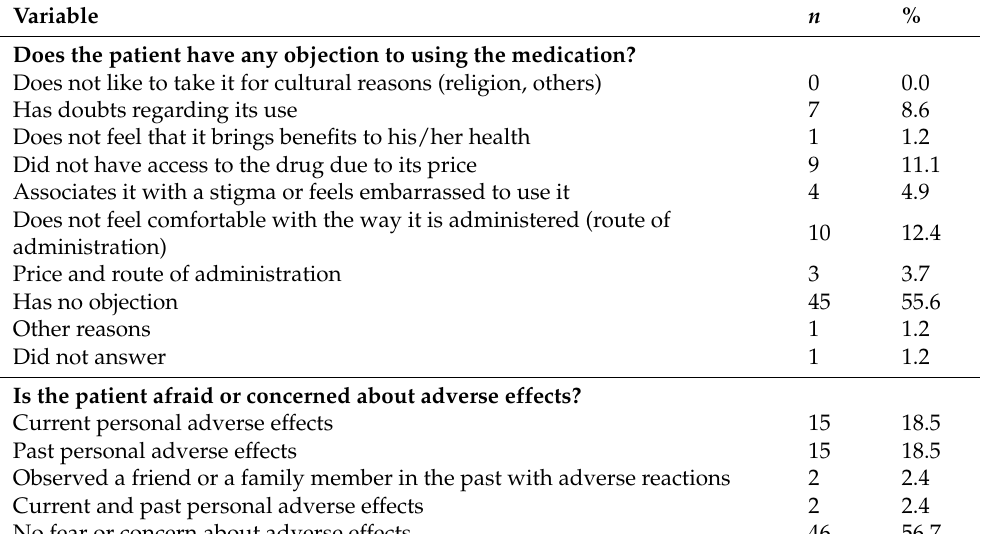
Table 2. Description of the experience with medication use among patients with tuberculosis and HIV/AIDS at Hospital Eduardo de Menezes, city of Belo Horizonte, Brazil ( n = 81).